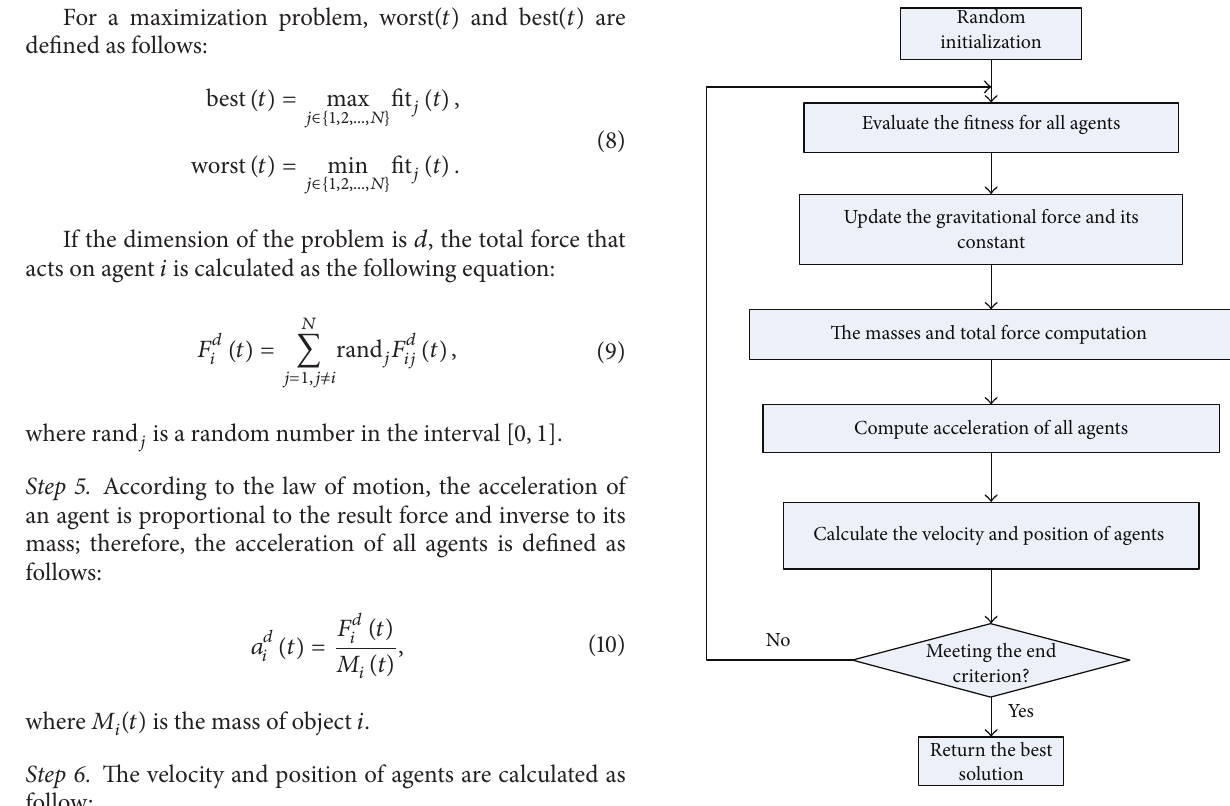
Figure 2: Hybrid PSOGSA algorithm flow chart.